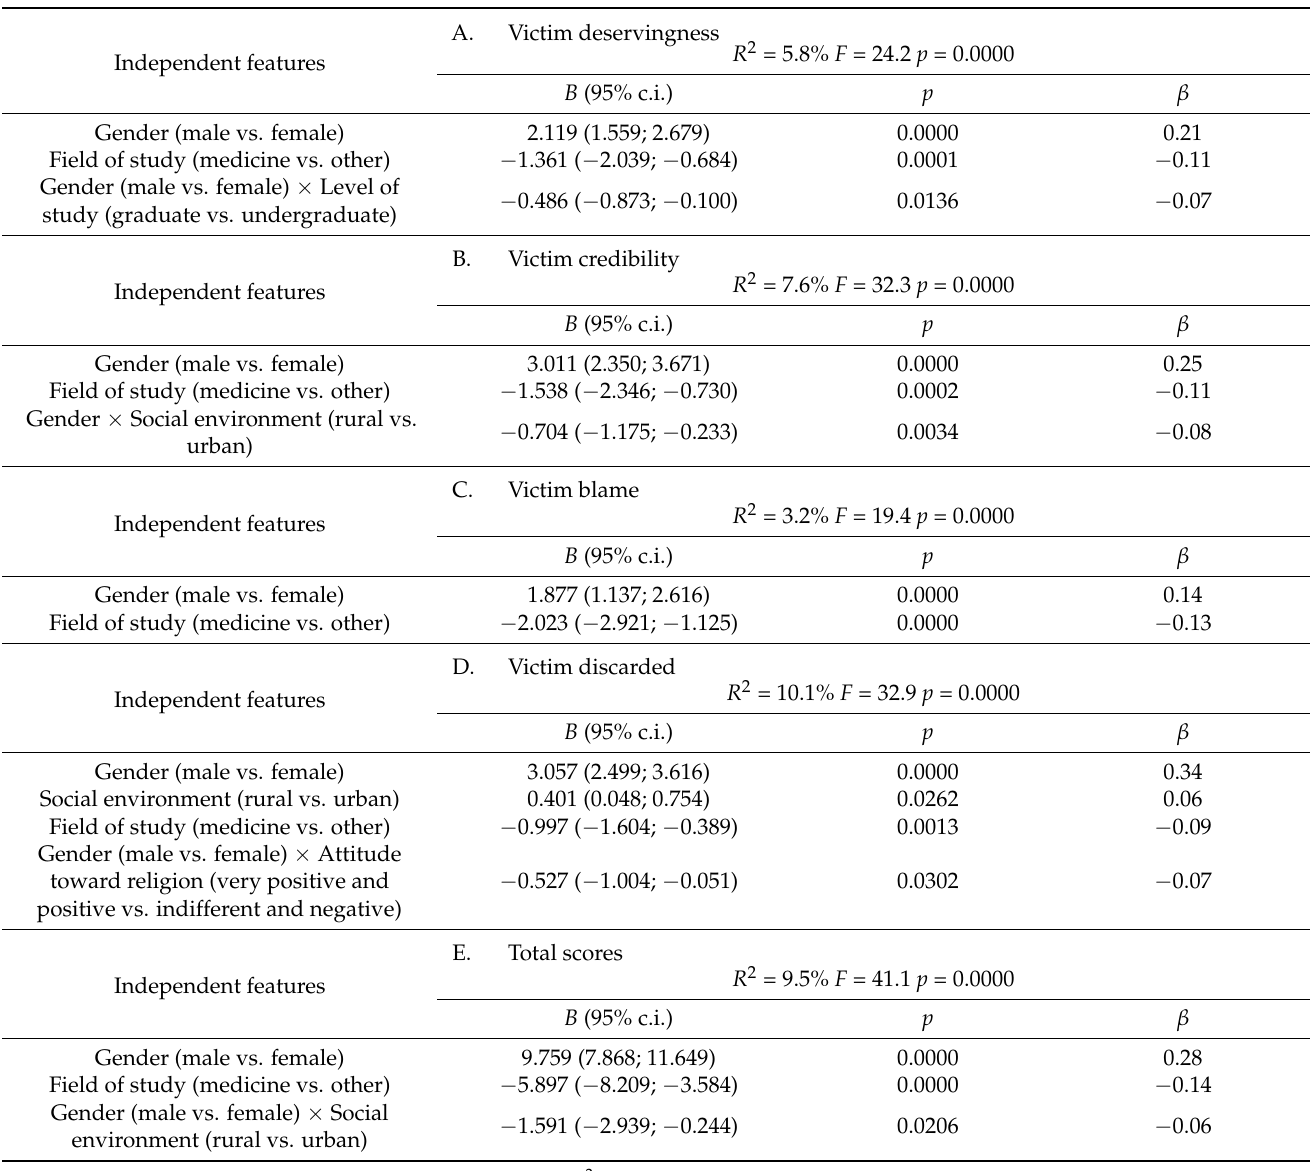
Table 5. Linear regression model containing only statistically significant factors differentiating the ARVS